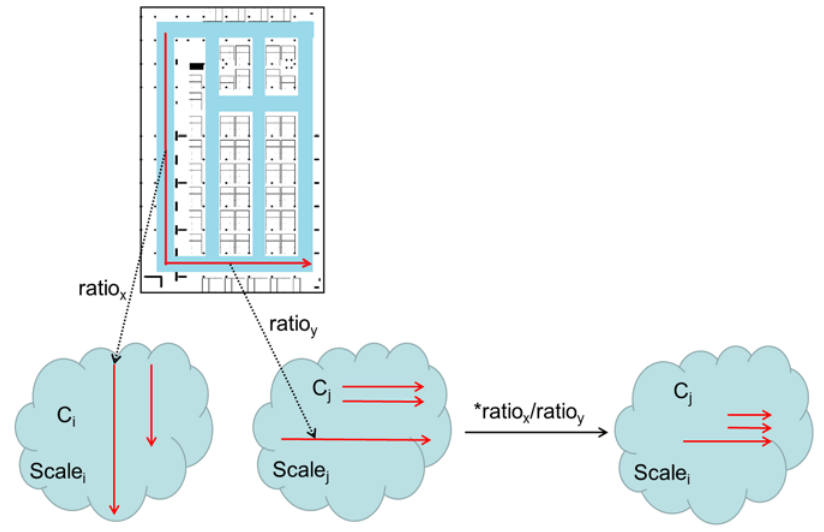
C be identical with C using the connections j i